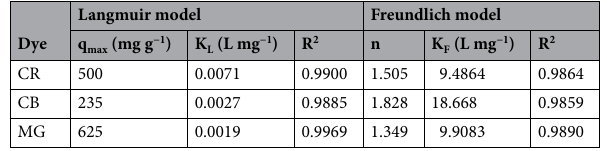
Table 1. The isotherm of CR, CB, and MG adsorptions on the FHAP-SH.